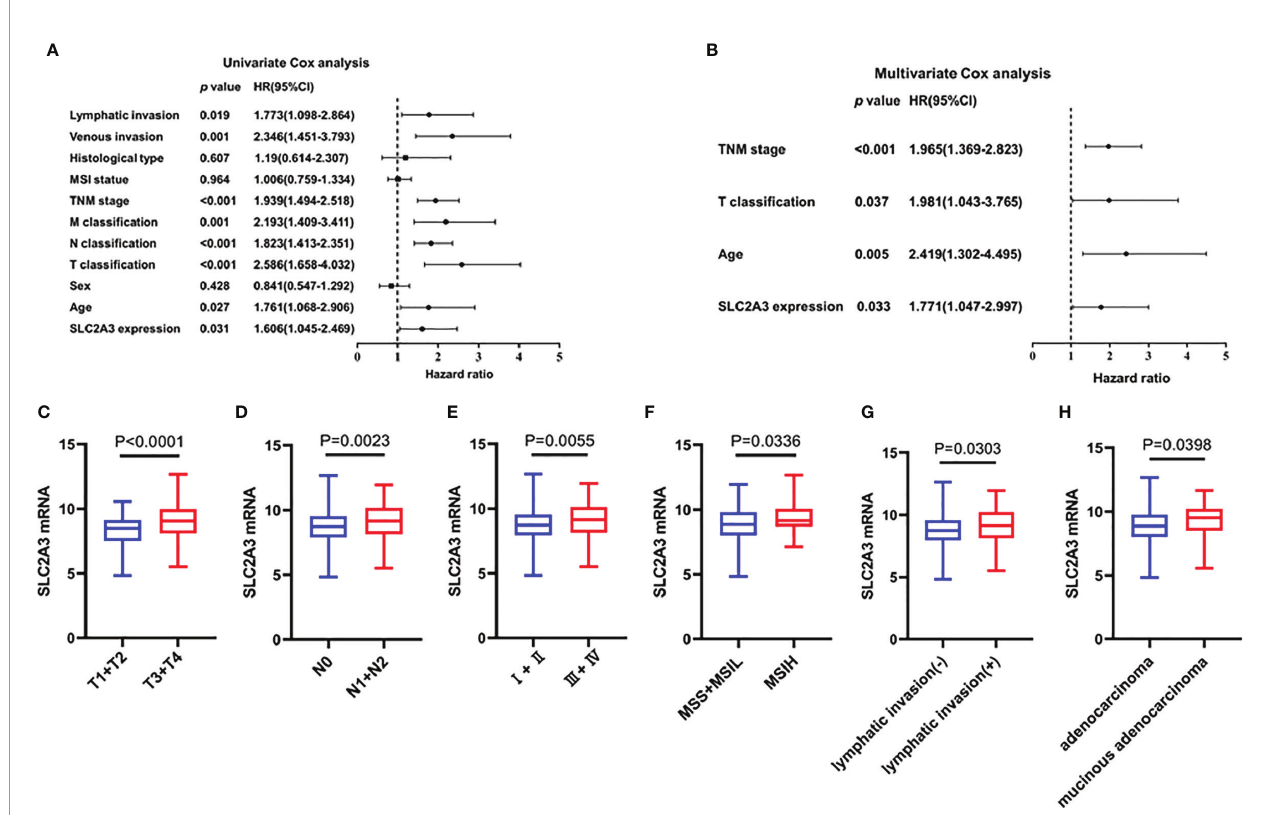
FIGURE 2 | SLC2A3 expression was associated with clinicopathological features of CRC based on TCGA. (A) Univariate and (B) multivariate Cox analysis of SLC2A3 expression and clinicopathological variables. SLC2A3 expression associated with (C) increased invasive depth, (D) lymph node metastasis, (E) higher stage, (F) MSI-H, (G) lymphatic invasion, and (H) mucinous